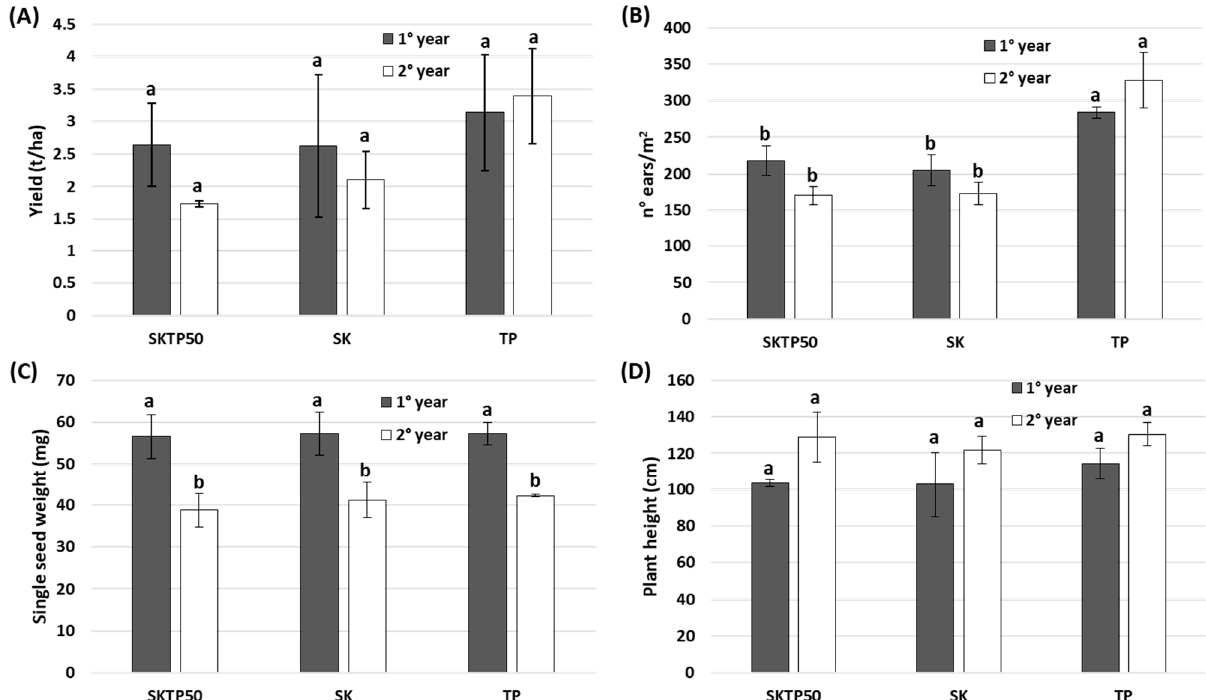
Figure 3. The measured yield ( A ), n ◦ ears/m 2 ( B ), single-seed weight ( C ) and plant height ( D ) of three rye varieties in Varchignoli. For each parameter measured, different letters indicate statistically significant differences (Tukey’s test, p < 0.05).